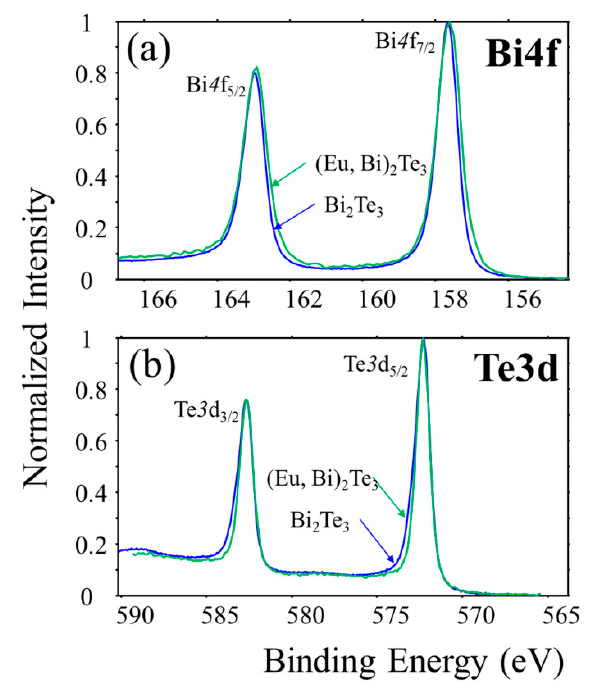
Figure 4. XPS spectra of ( a ) Bi 4f and ( b ) Te 3d levels for undoped and Eu doped Bi 2 Te 3 films.